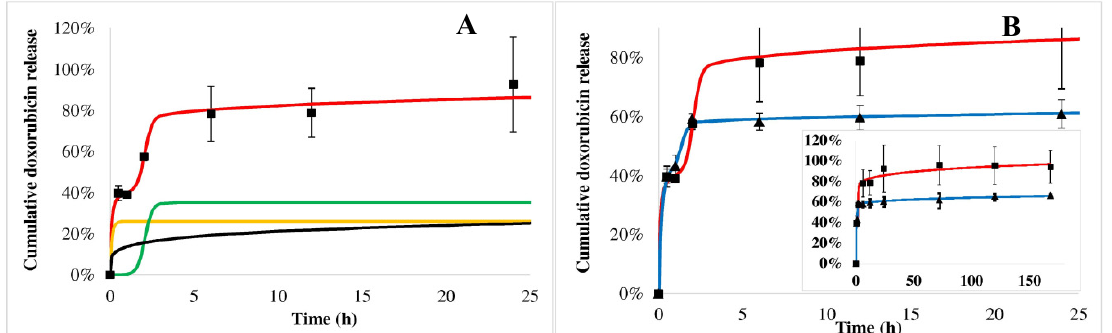
Figure 9. Doxorubicin cumulative release from PEGylated PHB nanoparticles measured in acid (squares) and blood plasma (trigons). Colored lines show the modeled release profiles as follows: red line draws the release kinetics in acid built from initial burst (yellow line), polymer degradation (green line) and diffusion (black line) in acid ( A ); blue line draws the release in blood plasma in the ( B ). In the insert ( B ), the measured data and the fitted release profiles can be seen on the whole time scale.